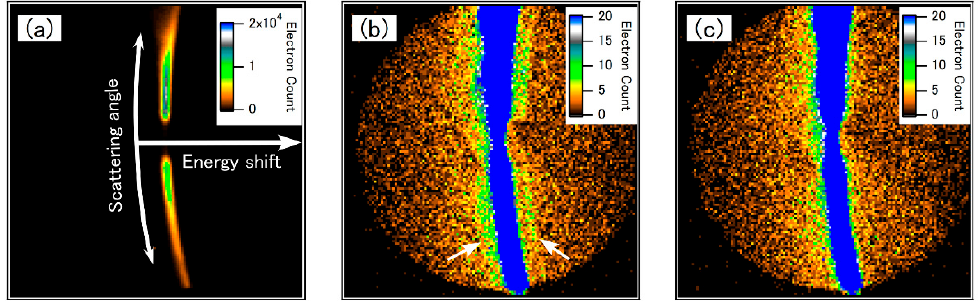
Figure 2. ( a ) The raw image of the electron scattering signals recorded when vertically polarized laser pulses ( Δ t = 200 fs, λ = 800 nm, and I = 1.8 × 10 12 W/cm 2 ) were introduced at the timing of the collision of 1 keV electron pulses by Xe atoms [9]. ( b ) The amplified image of ( a ). ( c ) The raw image of the background signals at the same intensity scale as ( b